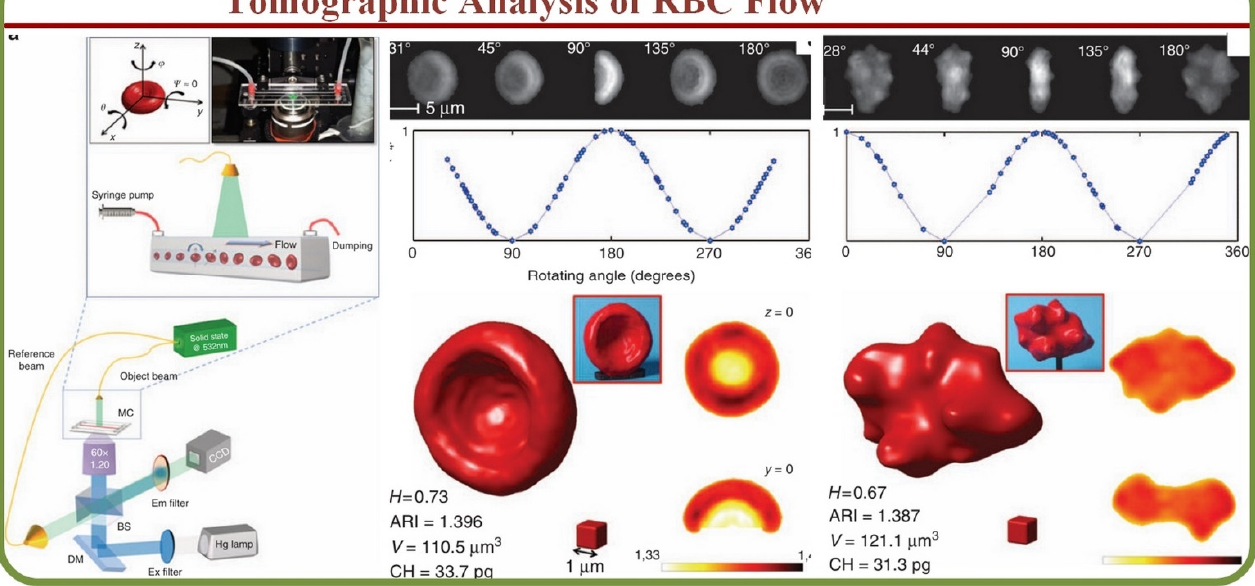
Figure 3. The tomographic analyses of RBC Flows. RBC tomographic flow cytometry by the digital holography. Healthy and morphological RBC anomaly phase images and 3D reconstructions [50].